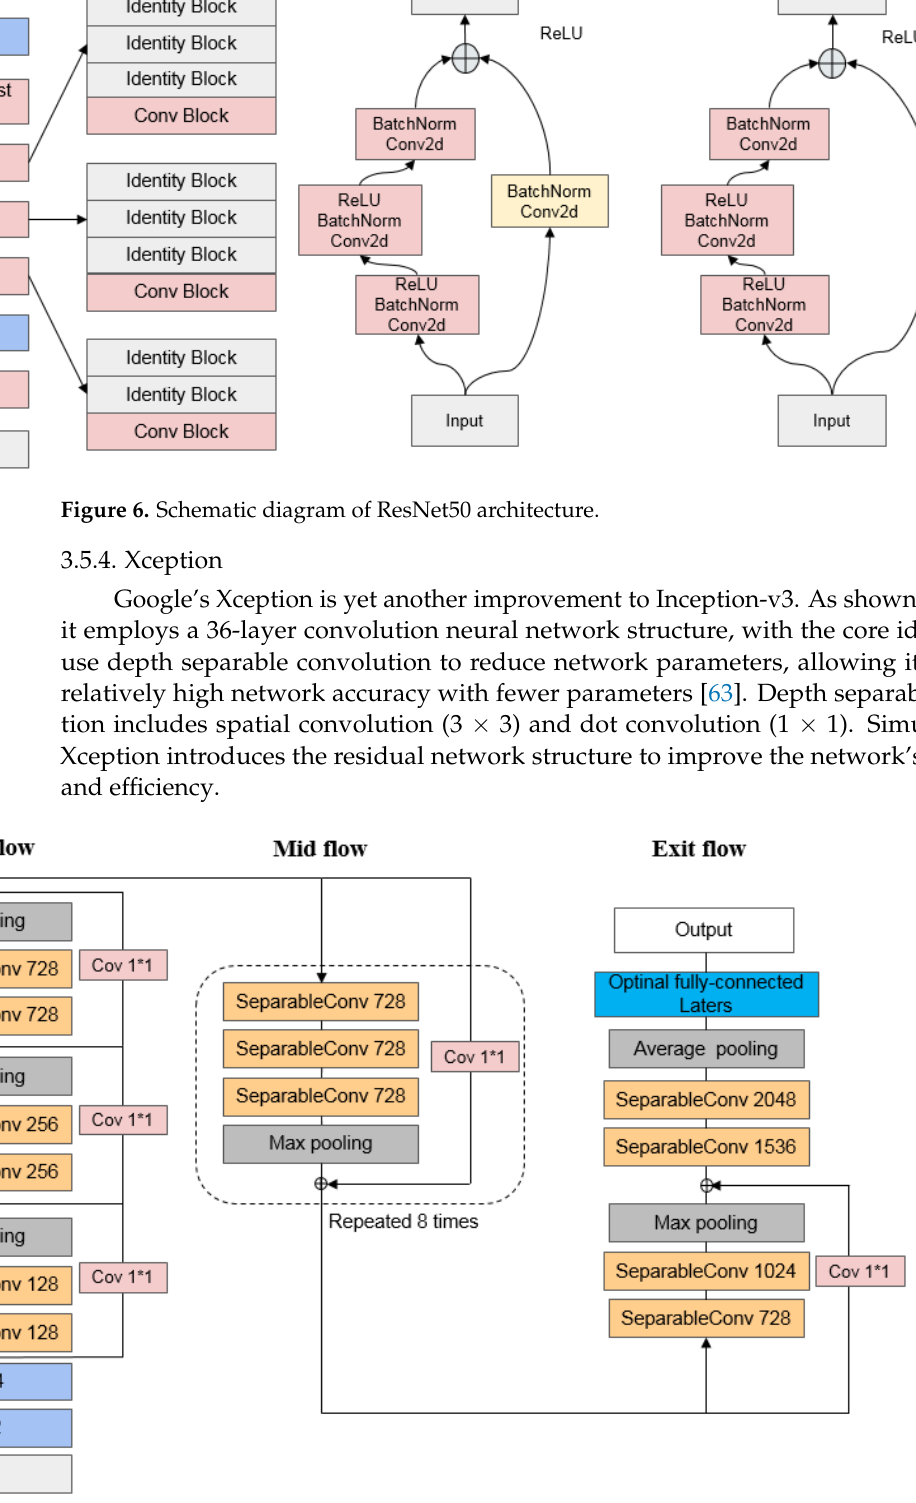
Figure 7. Schematic diagram of Xception architecture.